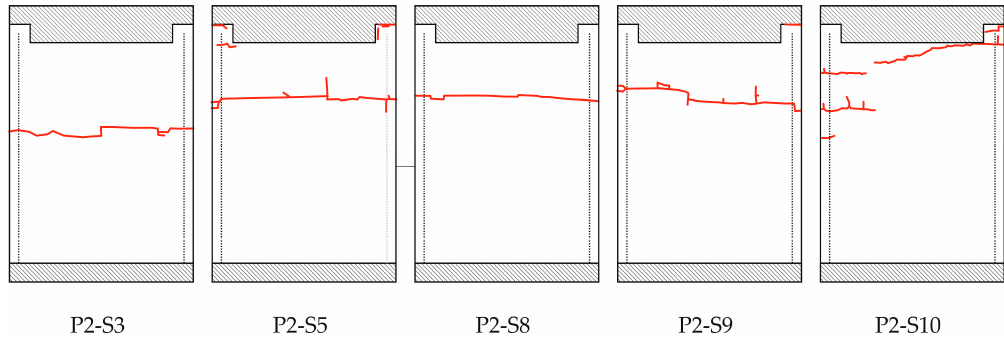
Table 1. Failure loads and place of fracture (also indicated in Figures 3 and 4) of different specimens for devices CAI-standard as well as CAI-modified with mean failure stress and standard deviation.